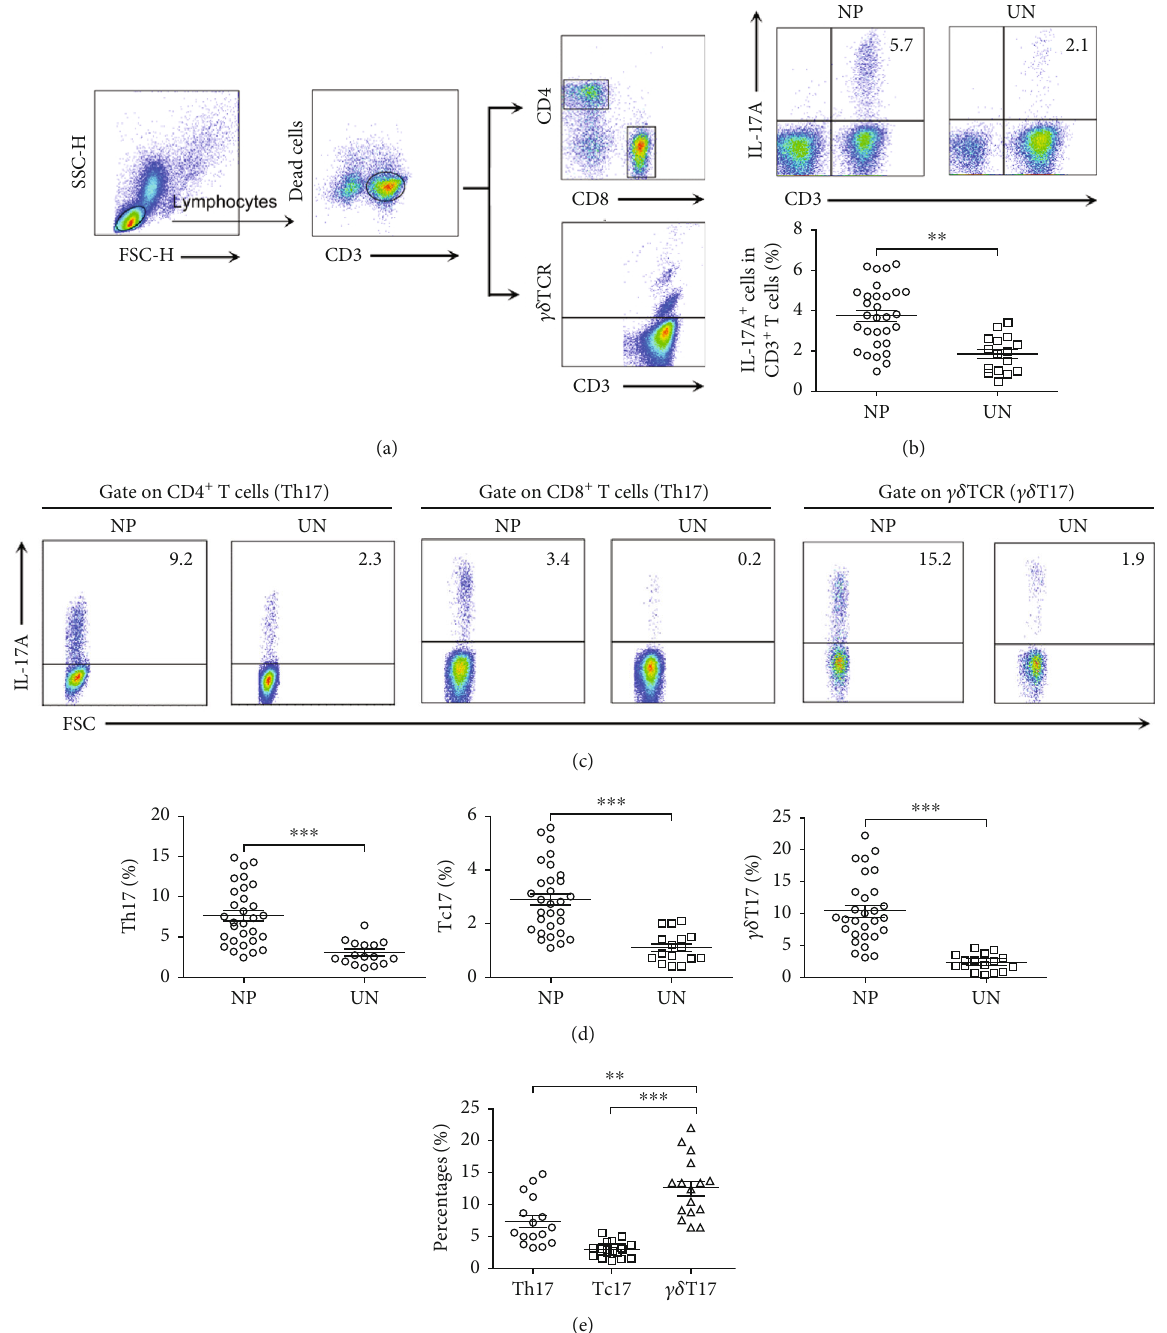
Figure 2: Both CD4 + , CD8 + , and γδ T cells expressed IL-17A in NP tissues. (a) FACS gating was used in the analysis of CD3 + T cells. (b) Representative FACS graphs and summary data showed the expression of IL-17A by CD3 + T cells in NP ( n = 30 ) and uncinate ( n = 16 ) tissues. (c, d) Representative FACS graphs and summary data showed the expression of IL-17A by CD4 + , CD8 + , and γδ T cells in NP ( n = 30 ) and uncinate ( n = 16 ) tissues. (e) Summary data showed the percentages of Th17, Tc17, and γδ T17 cells in NP tissues ( n = 16 ). Data were shown as the mean ± SEM . Statistical signi fi cance was determined with the Mann – Whitney test. ∗∗ p < 0 : 01 ; ∗∗∗ p < 0 : 001 . NP: nasal polyp; UN: